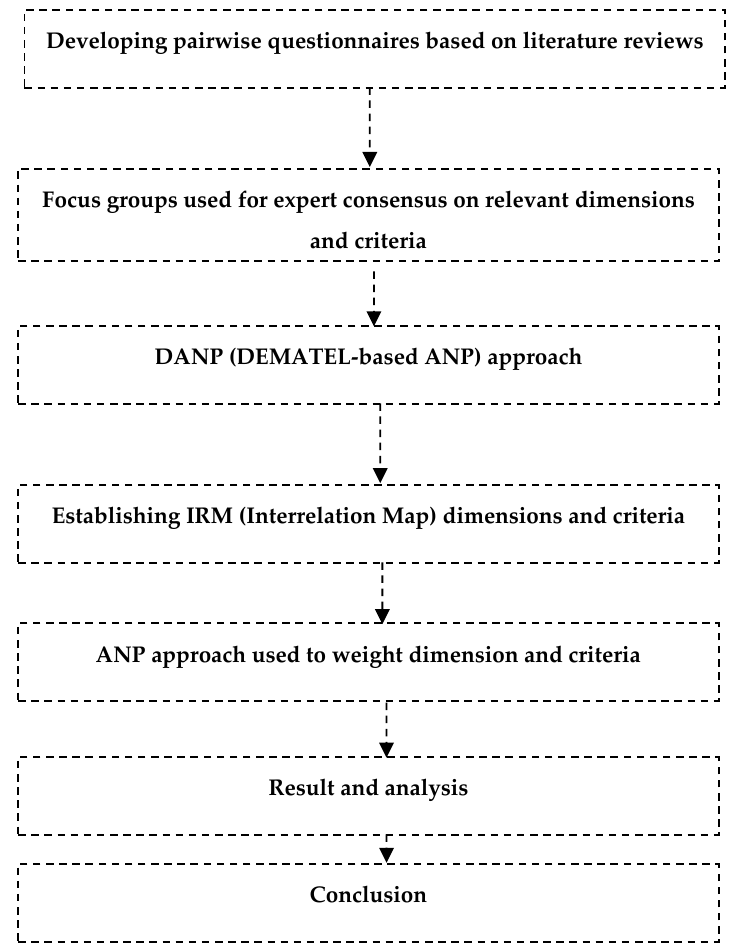
Figure 6. Flowchart of the proposed research design.